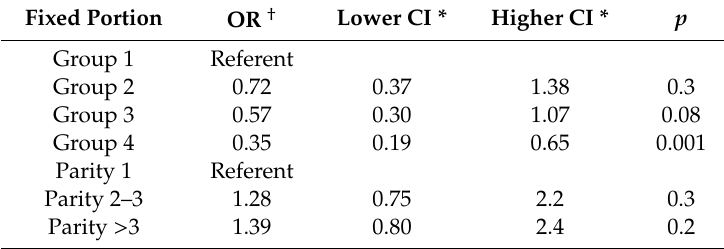
Table 2. E ff ect of treatment and parity at breeding on the likelihood of farrowing.